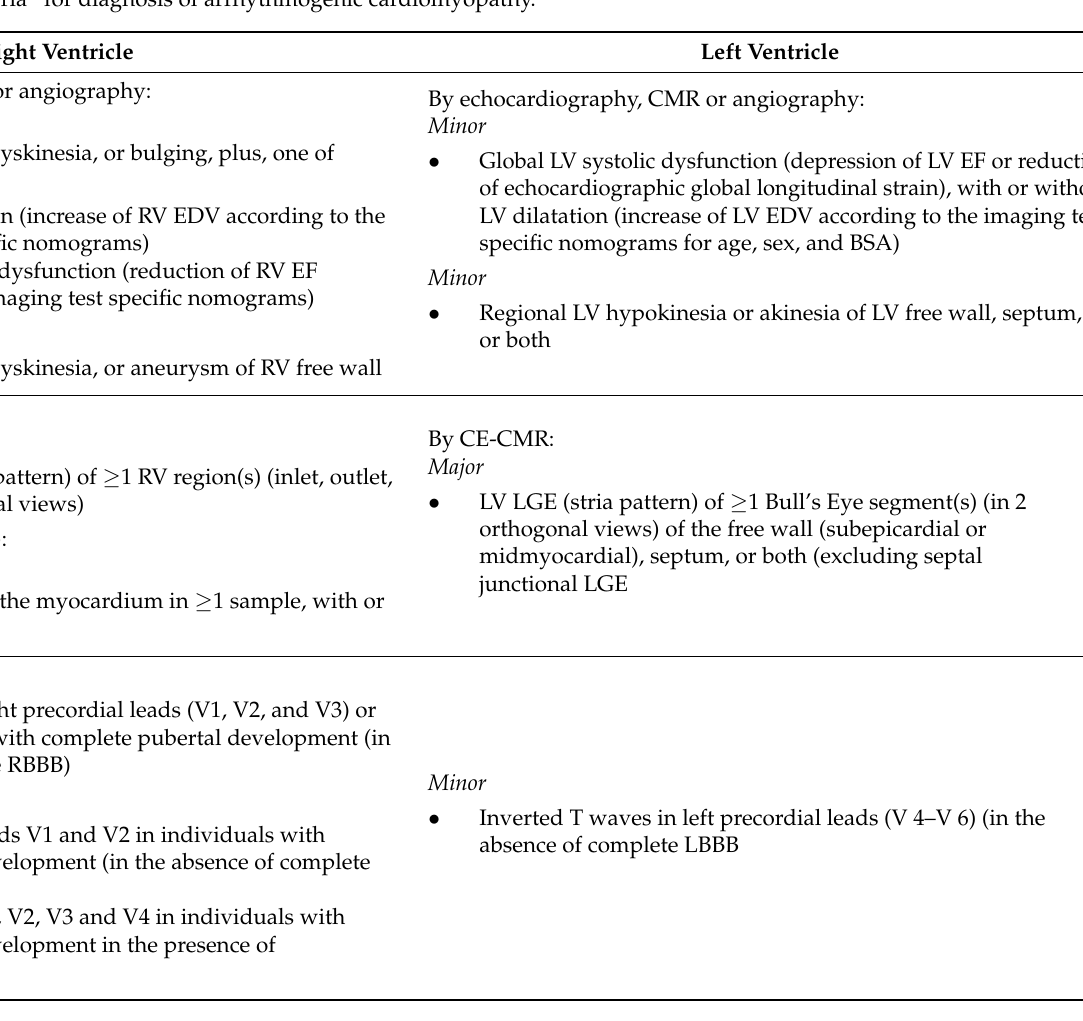
Table 2. “Padua criteria” for diagnosis of arrhythmogenic